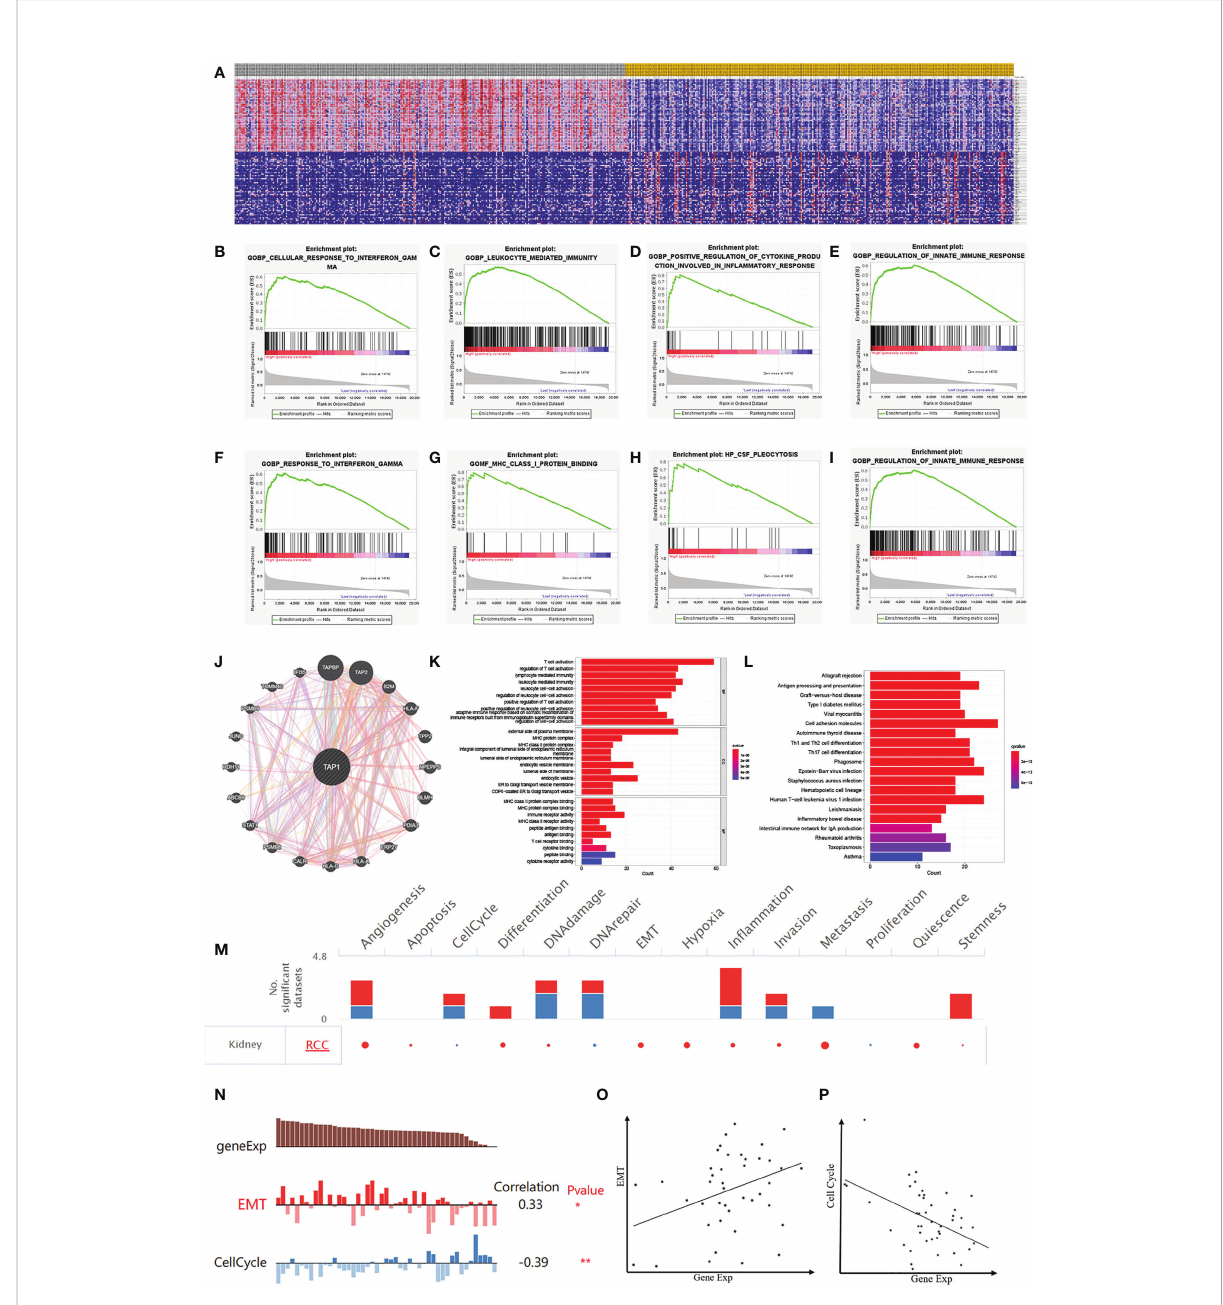
FIGURE 7 Potential Biological Functions of TAP1 of ccRCC. (A) Heatmap shows Differentially Expressed Genes (DEGs) between low- and high-TAP1 expression groups obtained from TCGA database. (B-I) Gene Set Enrichment Analysis (GSEA) analysis indicated high expression of TAP1 is enriched in functional states including cellular response to interferon-gamma (B) , leukocyte-mediated immunity (C) , positive regulation of cytokine production involved in an in fl ammatory response (D) , regulation of innate immune response (E) , and response to interferon-gamma (F) , MHC class I protein binding (G) , CSF pleocytosis (H) , regulation of innate immune response (I) . (J) Protein ‐ protein interaction (PPI) network showed factors signi fi cantly coregulated with TAP1. (K) Gene Ontology (GO) function analysis of DEGs. The top group represents biological process (BP) group, the middle group represents cellular component (CC) group and the bottom group represents molecular function (MF) group. (L) Functional enrichment analysis of DEGs based on the Kyoto Encyclopedia of Genes and Genomes (KEGG) database, including allograft rejection, antigen processing and presentation, Graft-versus-host disease, Type I diabetes mellitus viral myocarditis, and so on. (M) The functional state of TAP1 in ccRCC based on CancerSEA. The red plots indicated that TAP1 is positively correlated with the functional state while the blue plots indicated that TAP1 was negatively correlated with the functional state identi fi ed by CancerSEA. (N) Single-cell analysis indicated that TAP1 is primarily involved in epithelial – mesenchymal transition (EMT) and Cell Cycle in ccRCC. (O) Correlation between TAP1 expression and EMT (Cor=0.33). (P) Correlation between TAP1 expression and Cell Cycle (Cor=